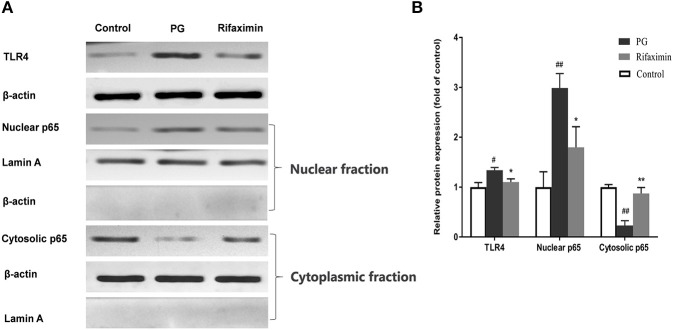
Rifaximin inhibits TLR4/NF-kB pathway activation in AS mice. (A) Representative western blots for TLR4, nuclear p65, and cytosolic p65 proteins. (B) TLR4 and cytosolic p65 protein expression quantified using densitometric analysis with β-actin as an internal control. Lamin A was used as a loading control for nuclear p65. Data are presented as means ± standard deviation from five mice per group (#P < 0.05, and ##P < 0.01 vs. control; *P < 0.05, and **P < 0.01 vs. PG alone).